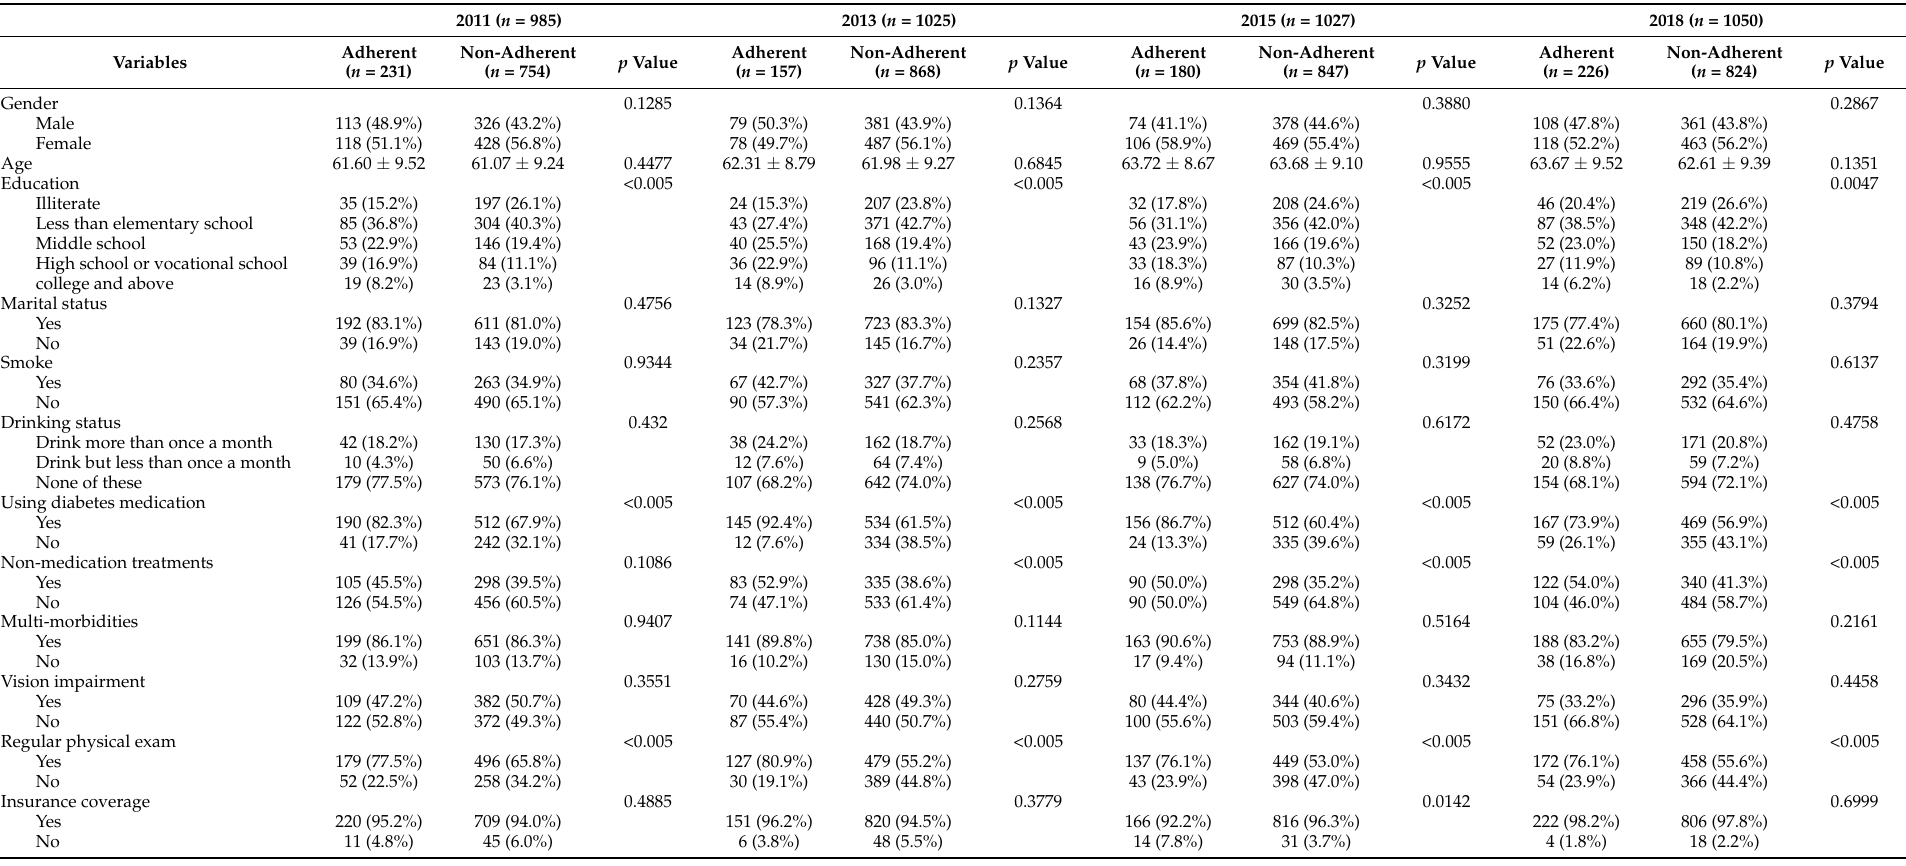
Table 1. Descriptive characteristics of study sample from 2011 to